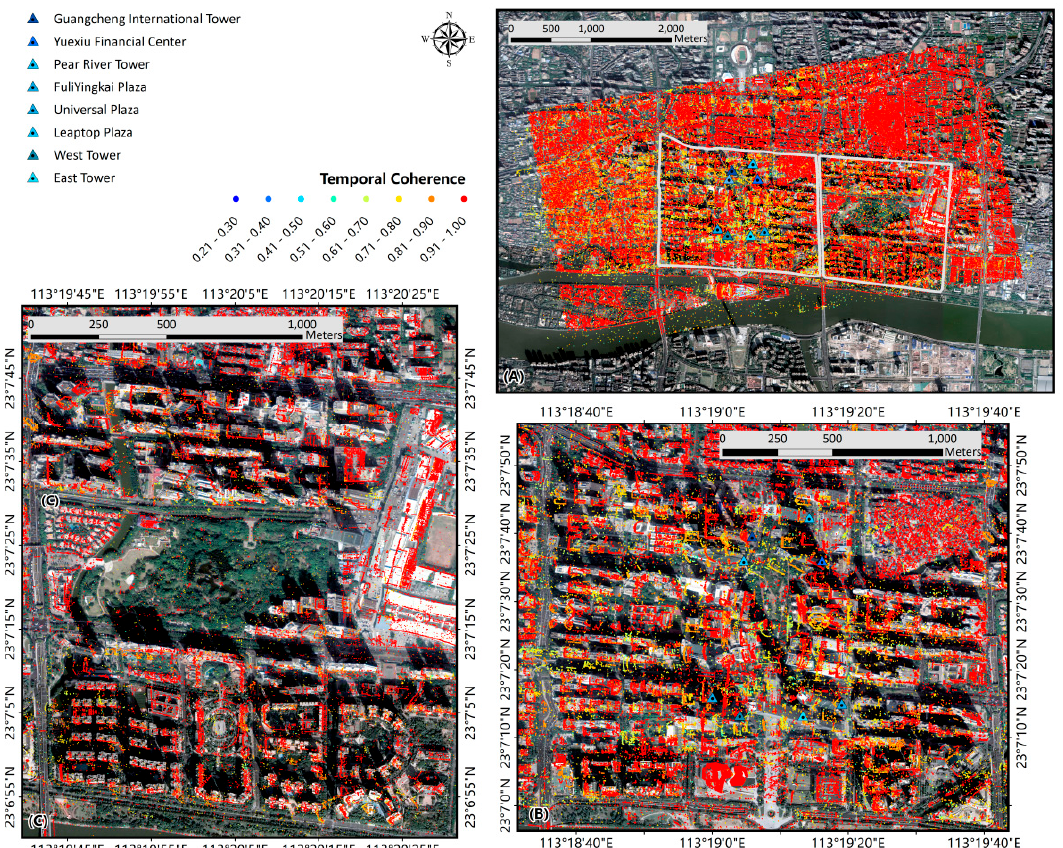
Figure 5. Temporal coherence map of the selected persistent scatterer candidates in the standard processing result: ( A ) The whole study area; ( B ) Subset of the map in test region A; ( C ) Subset of the map in test region B.